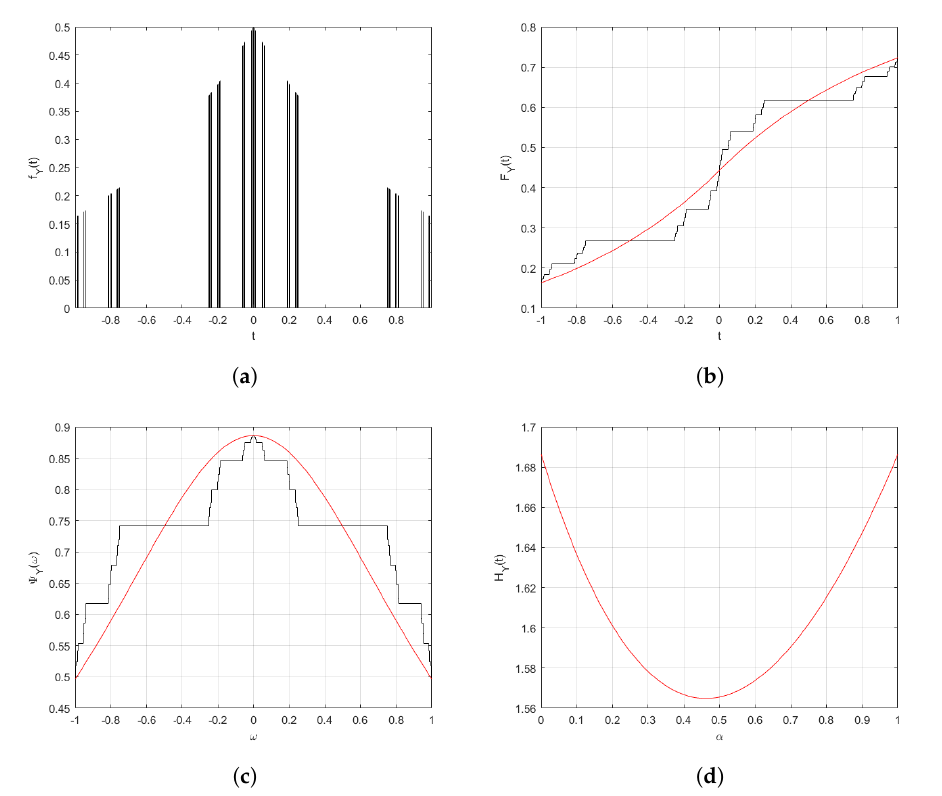
Figure 3. Figures for Example 2. ( a ) Probability density function of a fractal Laplace random variable with c = 1, α = 0.5, β = 2, ν = 0; ( b ) distribution function of a fractal Laplace random variable with c = 1, α = 0.5, β = 2, ν = 0; ( c ) characteristic function of a fractal Laplace random variable with c = 1, α = 0.5, β = 2, ν = 0; ( d ) entropy of a fractal Laplace random variable with c =